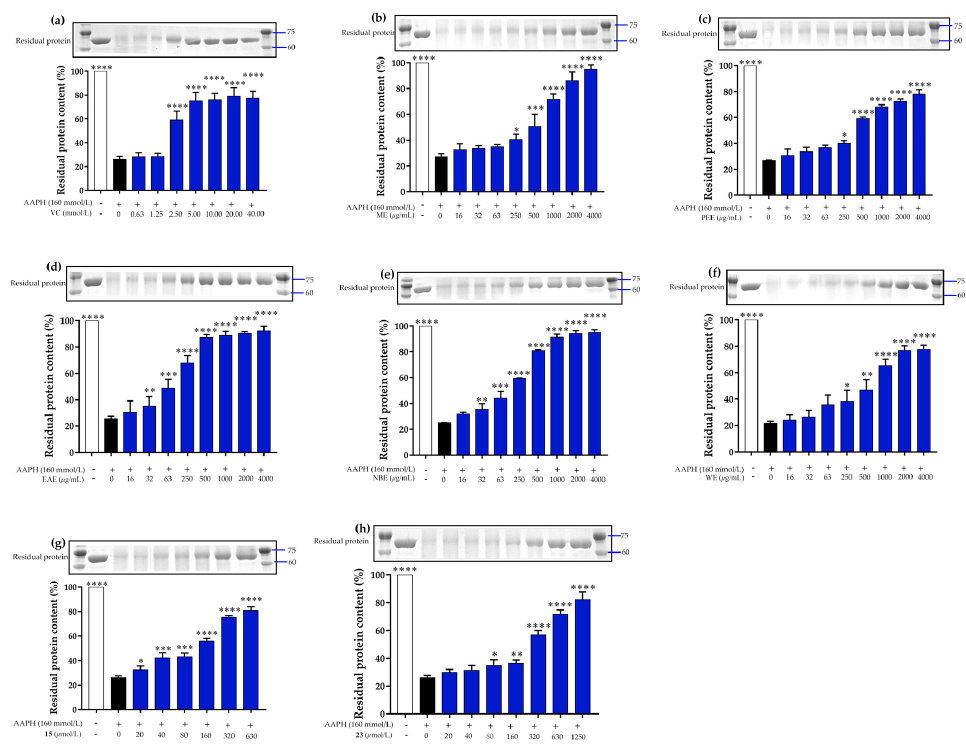
Figure 4. Prevention of AAPH − induced protein oxidative damage by T. grandis methanolic extract, fractions and compounds 15 and 23 . ( a ) Prevention of AAPH − induced protein oxidative damage by VC (ascorbic acid). ( b ) Prevention of AAPH − induced protein oxidative damage by ME. ( c ) Prevention of AAPH − induced protein oxidative damage by PEE. ( d ) Prevention of AAPH − induced protein oxidative damage by EAE. ( e ) Prevention of AAPH − induced protein oxidative damage by NBE. ( f ) Prevention of AAPH − induced protein oxidative damage by WE. ( g ) Prevention of AAPH − induced protein oxidative damage by compound 15 . ( h ) Prevention of AAPH − induced protein oxidative damage by compound 23 . − , inexistent; +, existent. Each group is compared with the model group, significance is denoted by symbols: * p < 0.05, ** p < 0.01, and *** p < 0.001, **** p < 0.0001 and all values are mean ± SD from three independent experiments. ME: